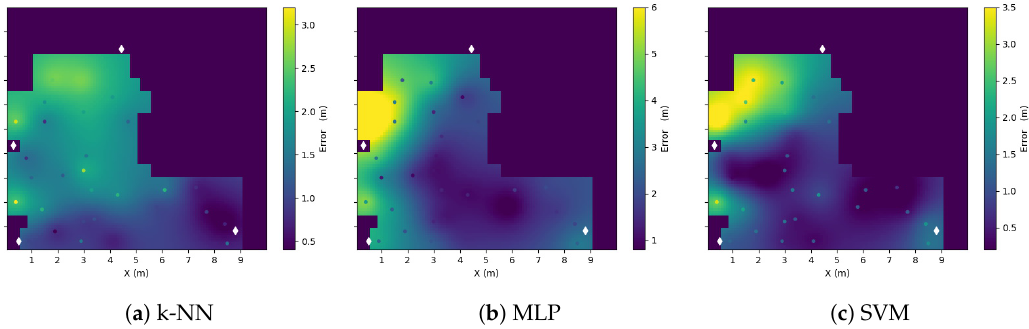
Figure 5. Error map of the three fingerprint-based methods in Environment A.